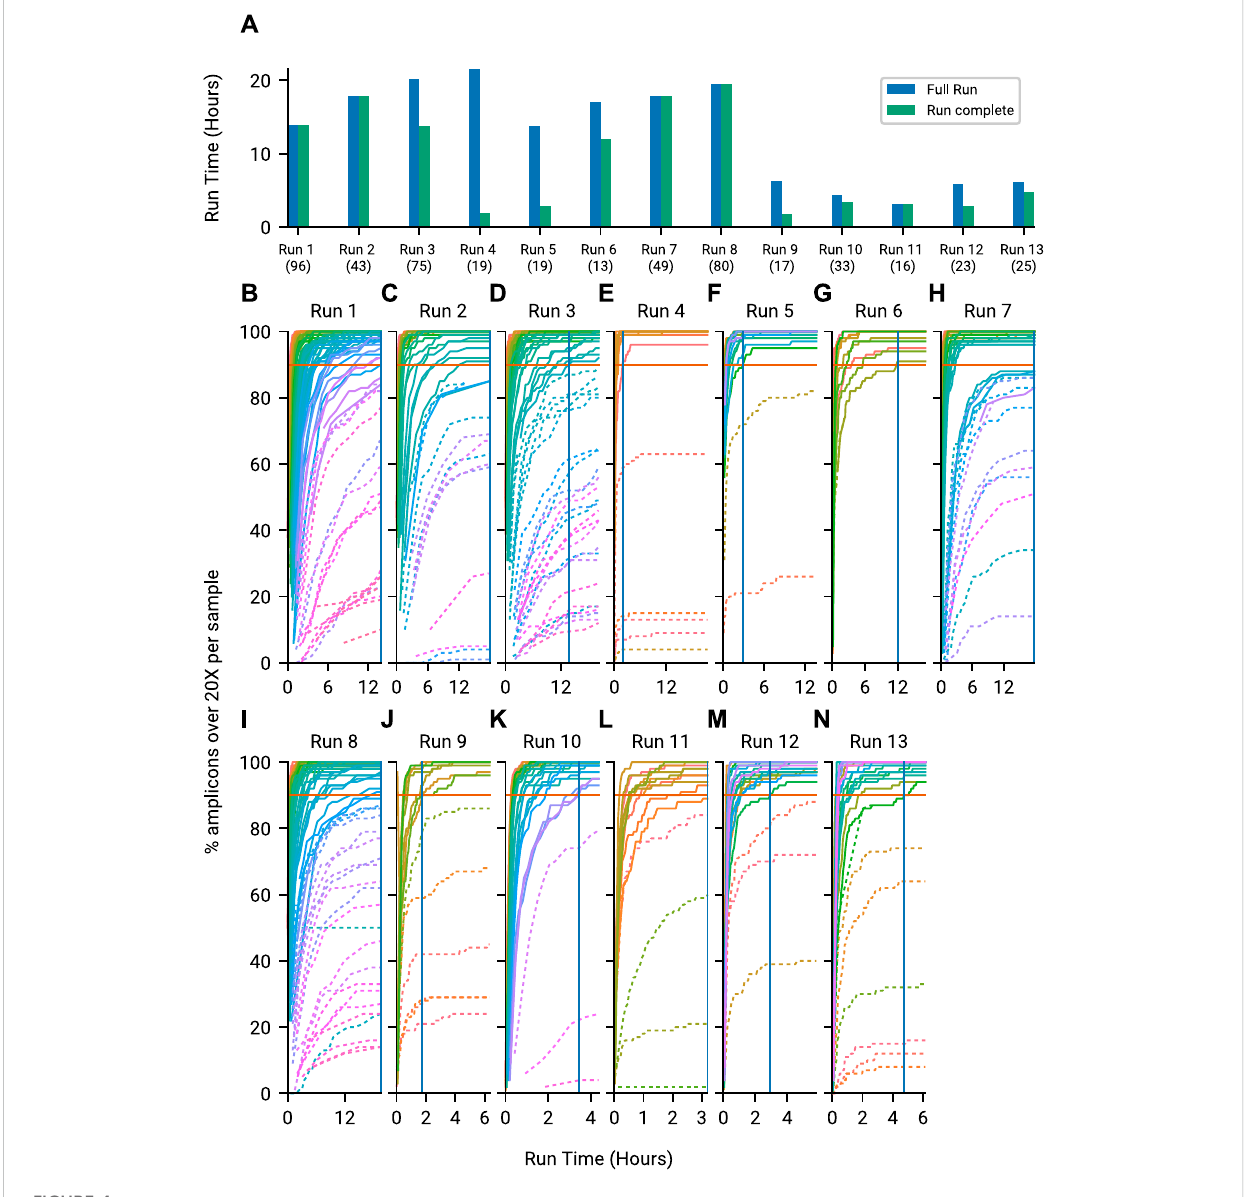
FIGURE 4 Time savings by using minoTours ARTIC Pipeline and amplicon coverages for each run, across the course of the run. (A) The Full Run time point plotted against minoTours Run complete time point as hours since the run started, for each run. Number of samples shown in brackets below the run label. (B – N) Samples across 13 runs showing the percentage of amplicons at 20× over time. Barcodes that we project to fi nish are displayed with solid lines,whilstbarcodes weproject notto fi nisharedashed.90% (Ourthreshold for fi ring)ismarkedoneachplot.Onceallbarcodesthatareprojected to fi nish cross the 90% threshold, we would instruct MinKNOW to stop the run. This time is marked by a solid blue vertical